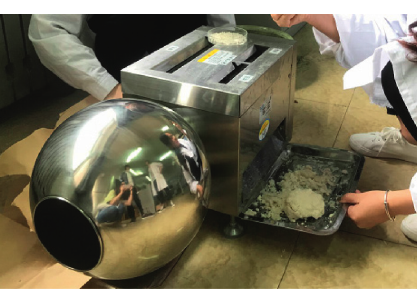
Figure 2: Core material granulation.